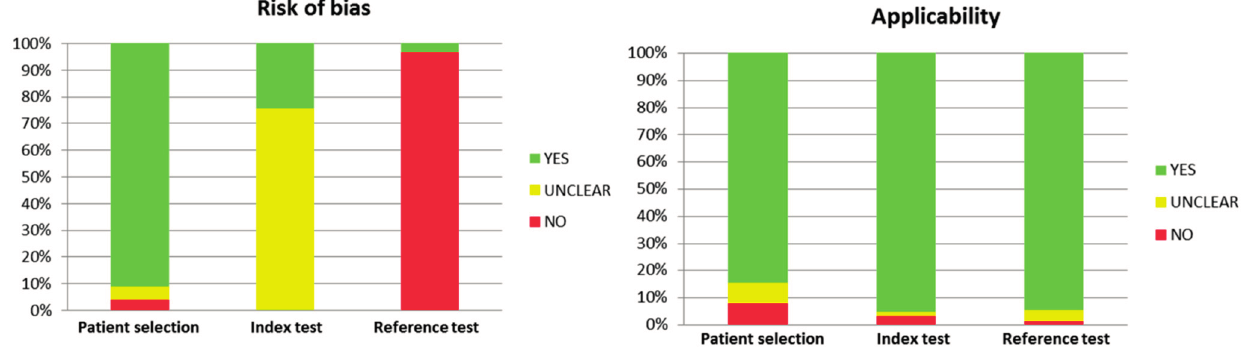
Figure 2. QUADAS-2 Quality score. QUADAS: Quality Assessment of Diagnostic Accuracy Studies.